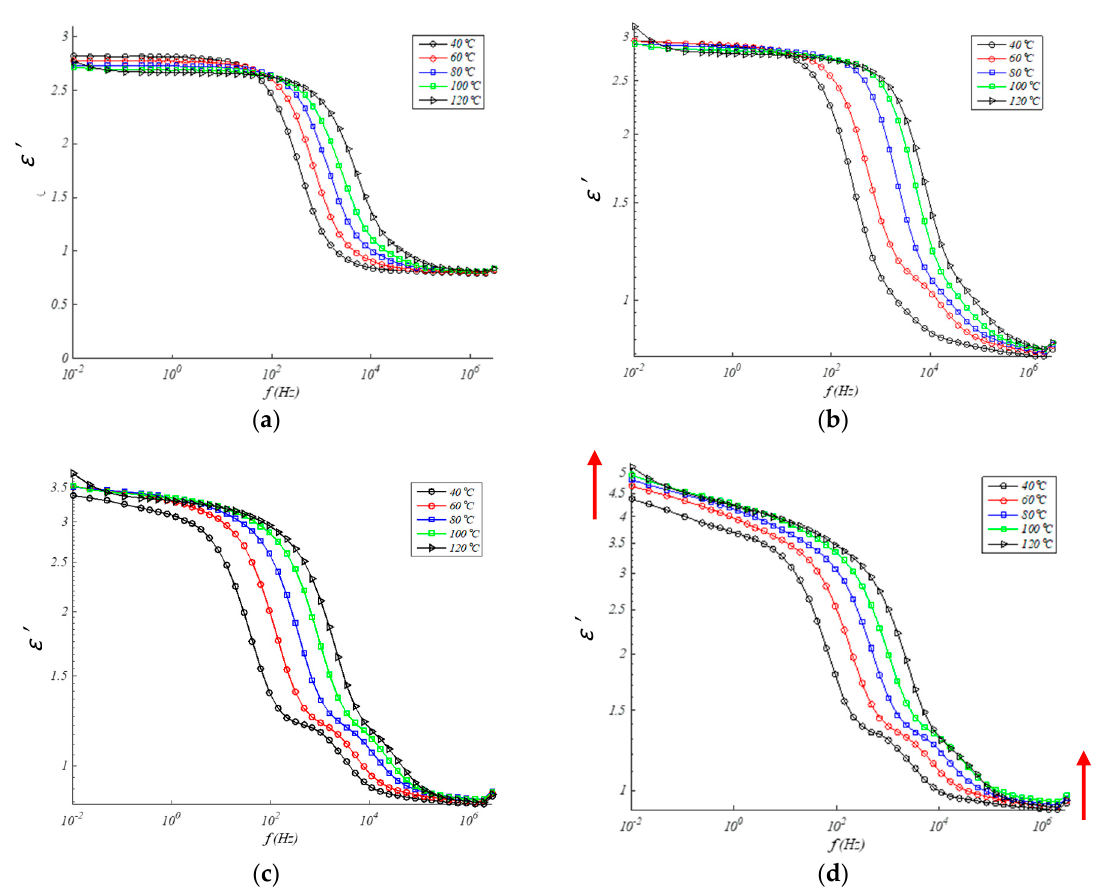
Figure 4. Real permittivity in EPDM composites for: ( a ) 0% GTR or neat EPDM; ( b ) EPDM + 5% GTR; ( c ) EPDM + 10% GTR; ( d ) EPDM + 20% GTR.